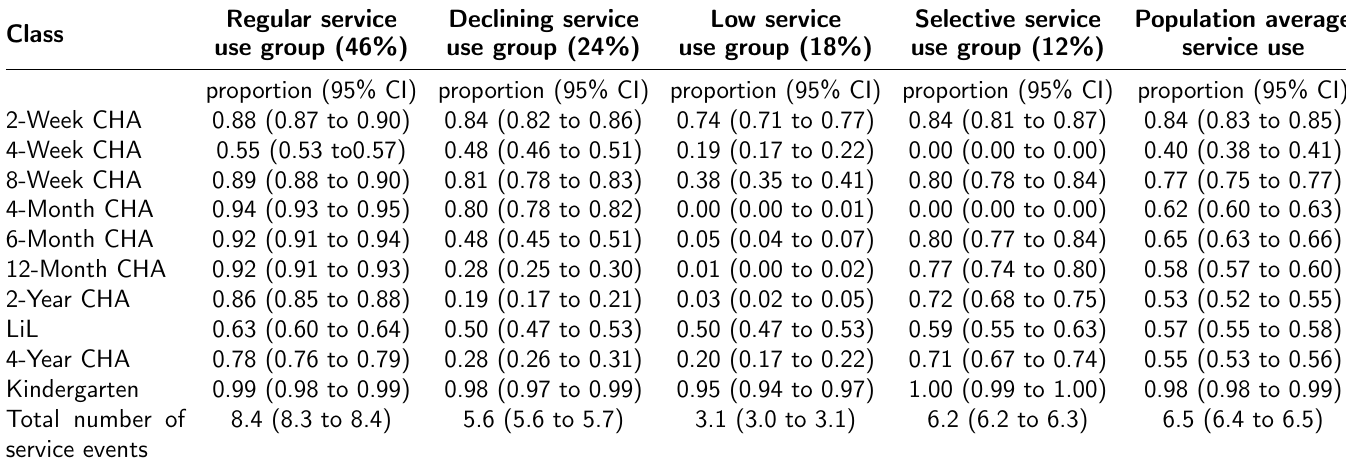
Table 1: The distribution of service events by service use group